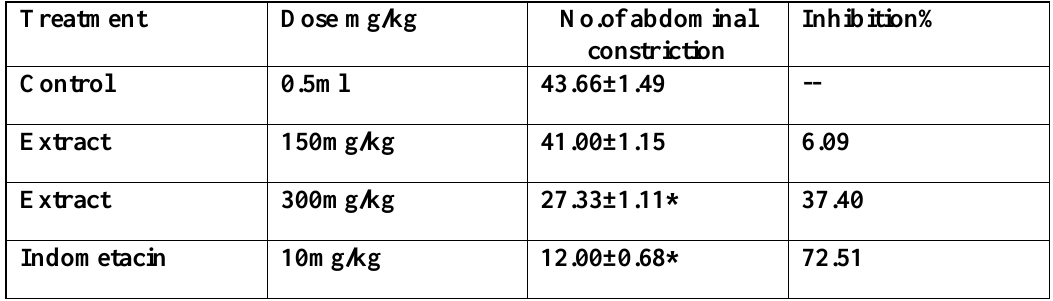
Table2: Shows the effect of Mentha piperita extract and indometacin on acetic acid- induced abdominal constrictions in